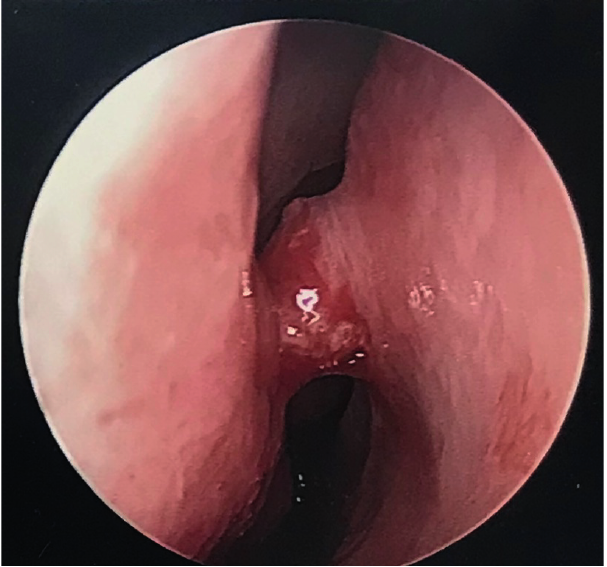
Figure 3. Endoscopic photograph of the right nasal cavity showing a 0.4 x 0.4 x 0.2 cm angioleiomyoma originating from the septum and extend- ing to the superior edge of the inferior turbinate.